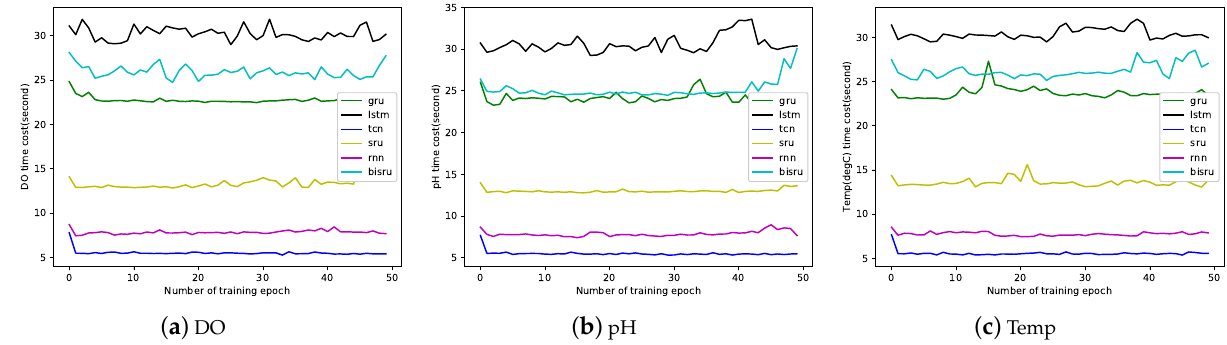
Figure 6. Comparison of training time under different models: ( a ) dissolved oxygen, ( b ) pH, ( c ) water